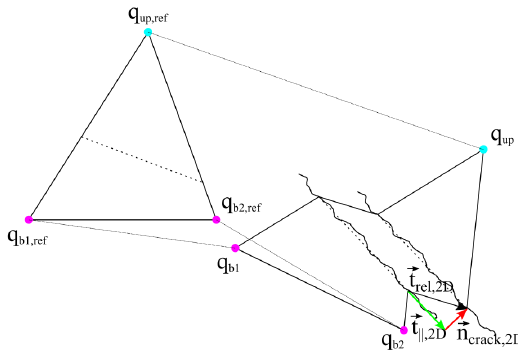
Figure 6. Movement of a triangle crossed by a crack. For the base line vertices, a Helmert transformation (rigid trans-